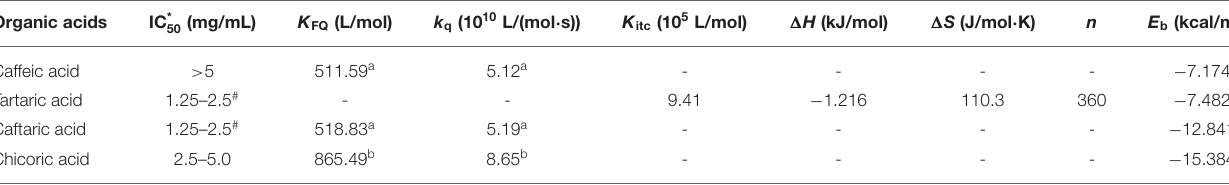
TABLE 1 | The constants that indicate the inhibitory activity and binding of organic acids with α -glucosidase. Organic